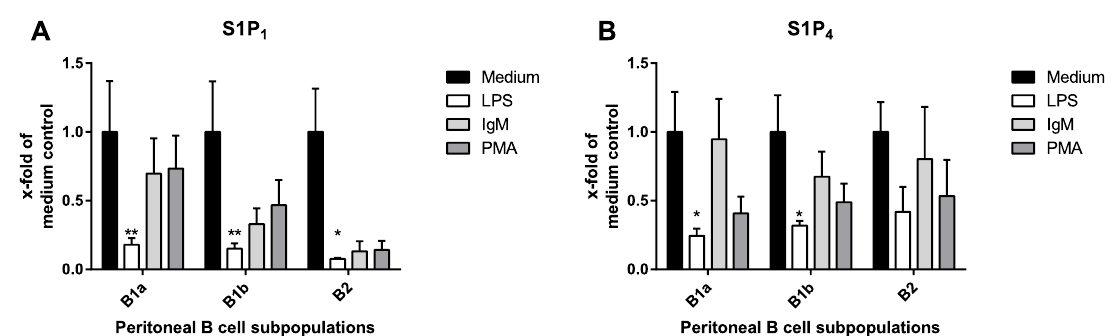
Figure 1. Expression of sphingosine-1-phosphate (S1P) receptor subtypes S1P 1–5 in peritoneal B cell subpopulations. After in vitro stimulation, sphingosine-1-phosphate receptor expression in peritoneal B cell subtypes was determined by quantitative polymerase chain reaction (qPCR). Gene expression was normalized to β 2 -microglobulin. Fold change in the mRNA expression of medium control for S1P 1 ( A ) and S1P 4 ( B ) receptor. p -values were computed based on the medium control from 2 −ΔΔCt -values using a Kruskal−Wallis test with Dunn’s multiple comparisons test. * p < 0.05, ** p < 0.01.